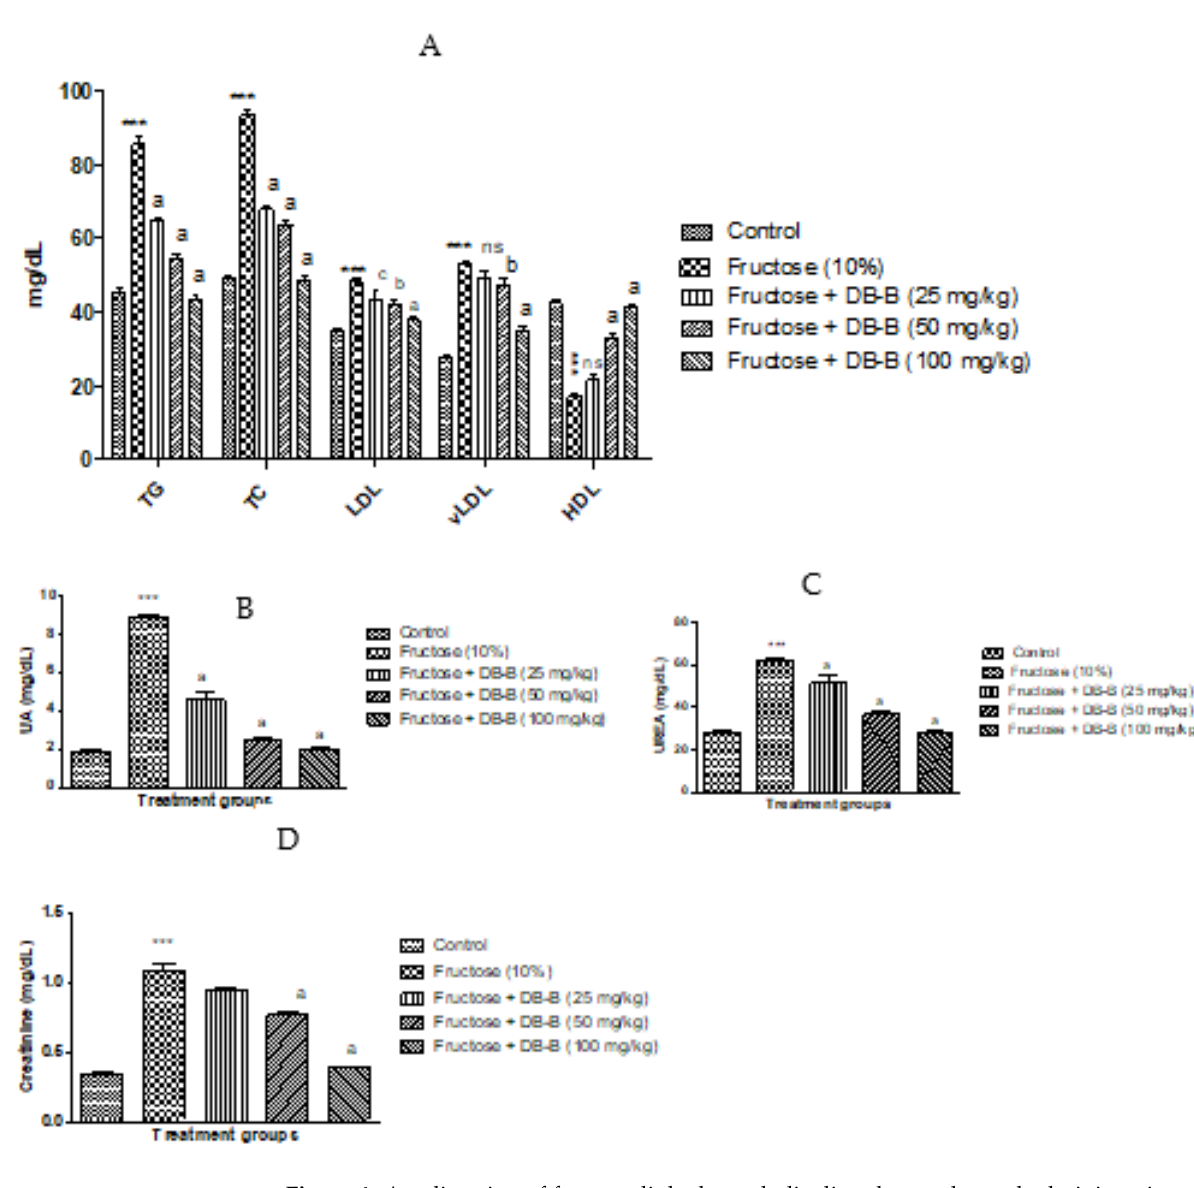
Figure 4. Amelioration of fructose-linked metabolic disturbances by oral administration of DB-B: ( A ) alteration in lipid profile, ( B ) decrease in level of uric acid, ( C ) level of urea, ( D ) decrease in level of creatinine. Each point is presented as mean ± SEM of five values where *** = p < 0.001 as compared with the control, while a = p < 0.001, b = p < 0.01, c = p < 0.05, and ns = non-significant in comparison with the results of the fructose (10%) group. Here, UA: uric acid, DB-B: butanolic fraction of D. brunonianum , TG: triglyceride, TC: total cholesterol, LDL: low-density lipoprotein, vLDL: very low-density lipoprotein, and HDL: high-density lipoprotein.